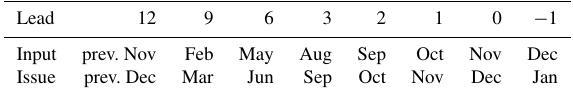
Table 3. Lead time definition of SSI DJFMAM forecast: time of input parameters (months abbreviated) and warning issue time.